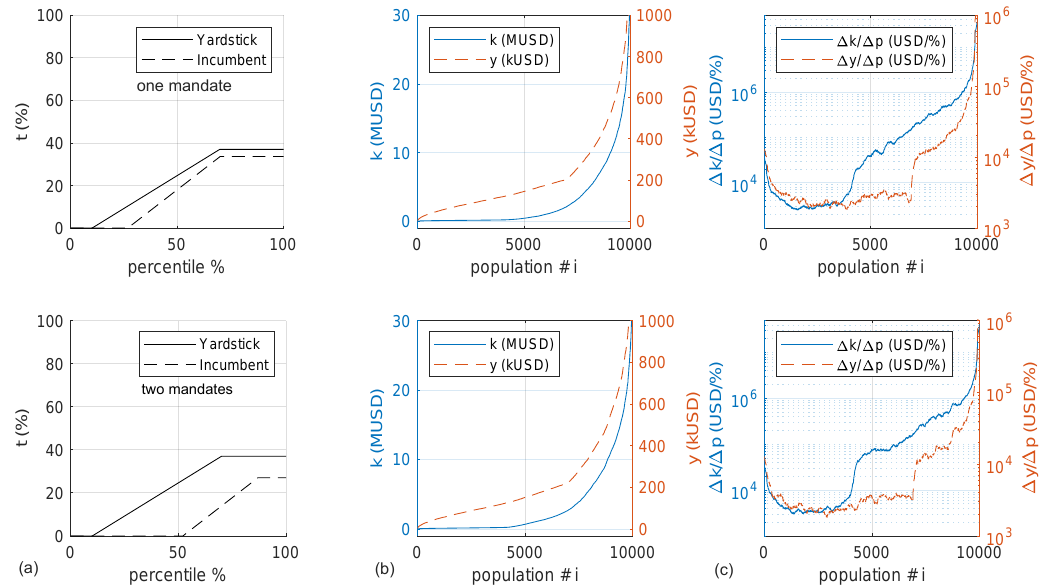
Figure 8. Top row: one mandate, bottom row: two mandates. From left to right: ( a ) Tax rate. ( b ) Distribution of capital and income in a 1 × 10 5 population after 73 years with Keynesian tax policy. ( c ) Differentiation of the wealth with respect to wealth percentile smoothed with a mean window of size 2%. Full results in the repository: https://doi.org/10.6084/m9.figshare.16442916.v3 (26